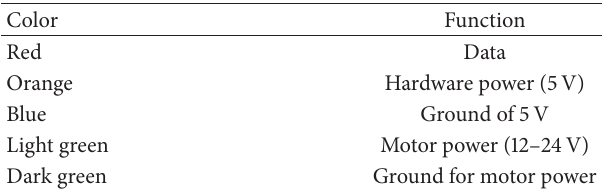
Table 1: Color codes of